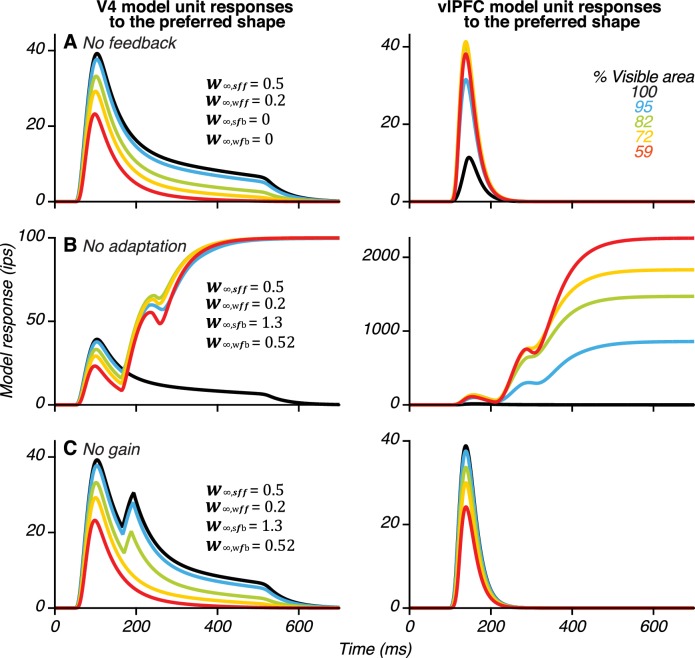
Demonstrating the necessity of feedback, synaptic adaptation and gain mechanisms in the model.(A) To demonstrate the necessity of feedback from vlPFC to V4, we set uPFC(j)i=0, for all i and j (see Equation 7 in Methods and materials). With only feedforward connections from V4 to vlPFC, the responses of the V4 unit (left) did not show a second transient peak. (B) To demonstrate the necessity of synaptic adaptation on the feedforward connections from V4 to vlPFC, the feedforward connection weights from V4 to vlPFC (wwffand wsff) were set to be constant over time (see Equation 9, Materials and methods). This resulted in ‘ringing’ and ‘blow up’ of V4 (left) and vlPFC (right) responses. (C) To demonstrate the necessity of gain-modulation, we set, f-PFC=30 (Equation 6, Materials and methods). In this case, vlPFC unit responses and V4 unit responses during the second peak resembled those during the first peak in V4: responses were strongest for unoccluded stimuli and declined with increasing occlusion level.